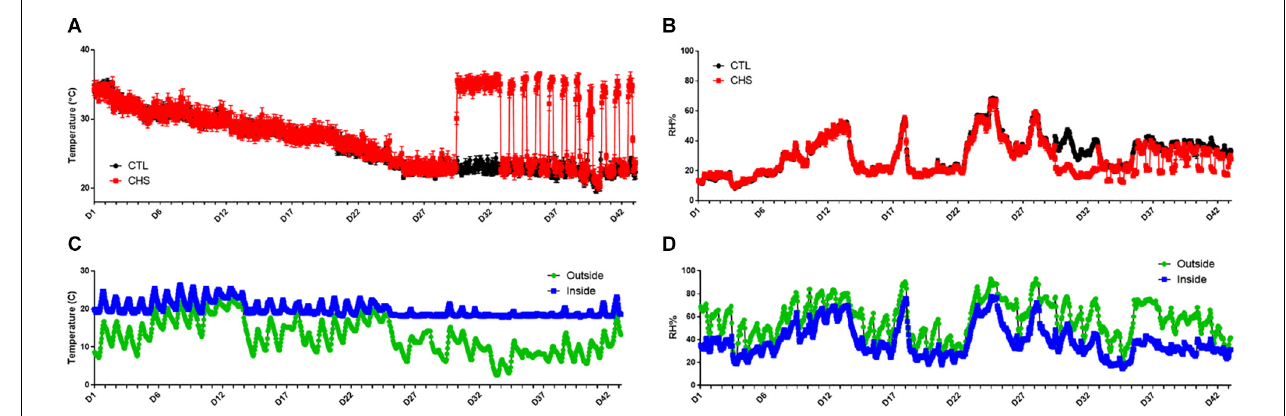
FIGURE 1 | Temperature and relative humidity (RH) fluctuation in the environmental chambers (A,B) , and inside and outside the barn (C,D) during the cyclic heat stress (CHS) experiment. Birds raised under recommended conditions from day 0 to 28. From day 29 to 42, birds either raised at thermoneutral temperature (CTL, 23 ◦ C) or exposed to CHS (35 ◦ C). Data are presented as mean ± SEM ( n = 1/chamber or 8/group).